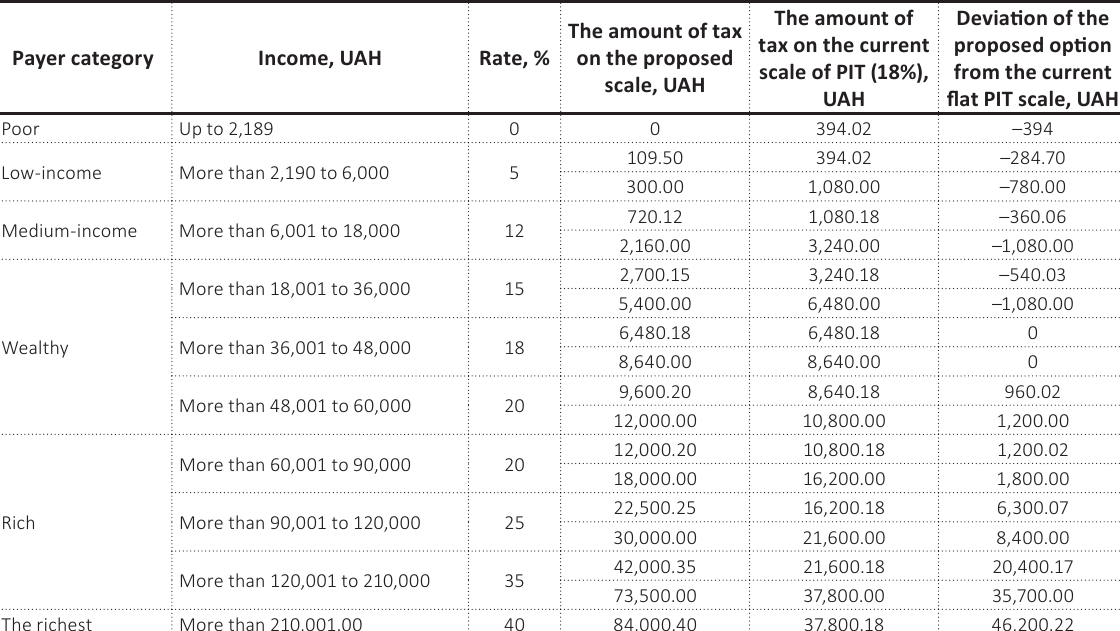
Source: Developed by the